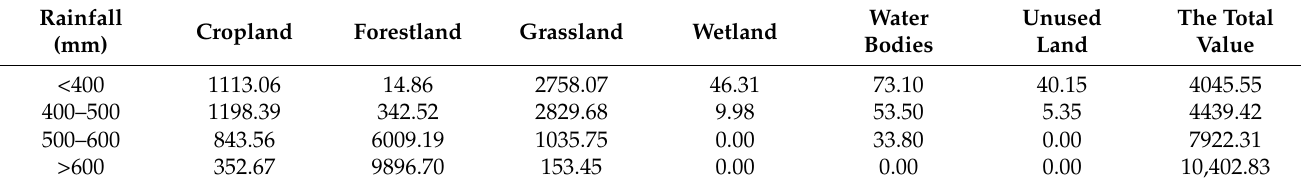
Table 5. ESV per unit area of different rainfall levels. Unit: CNY/hm 2